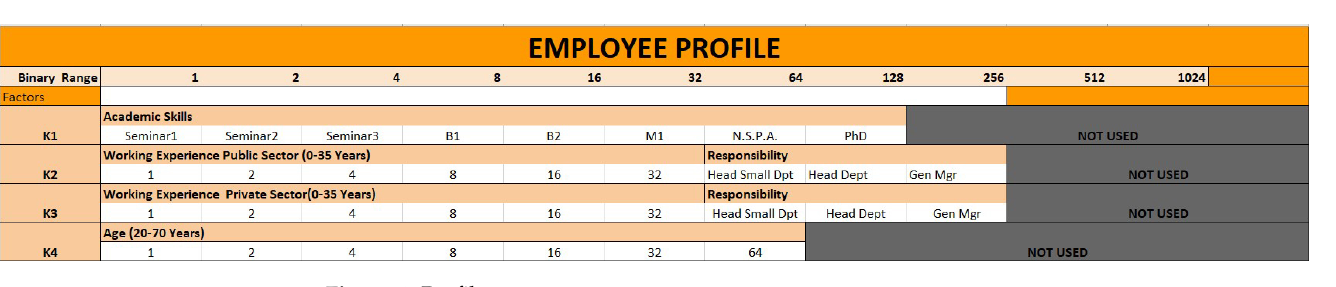
Figure 4. Profile structure.